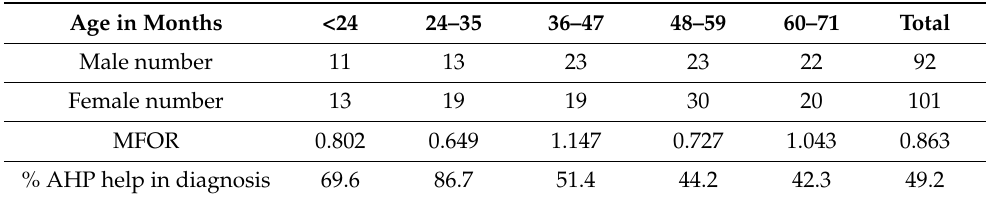
Table 7. Variables for sibling diagnosis by